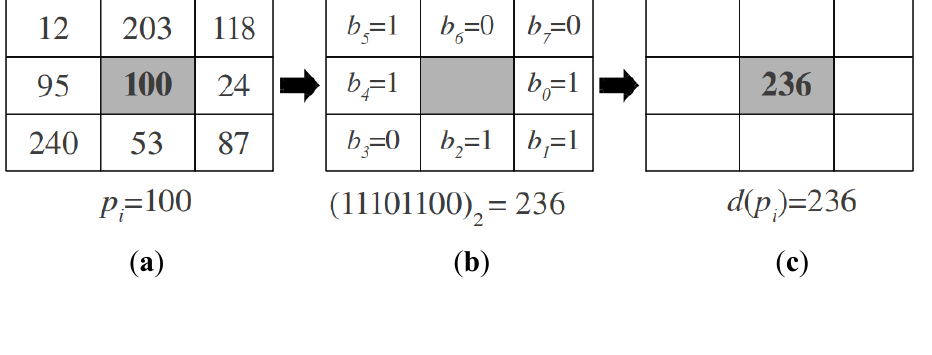
Figure 2. Toy example for the calculation of the LBP value of a pixel in a grey scale image. (marked in bold in a shadow cell) has an initial value of 100; ( a ) The reference pixel p i ( b ) Corresponding binary values for the 8-neighboring pixels of p into a binary string following a clockwise order starting at b value of 236; ( c ) The obtained decimal value is used as the new value for p transformed image T grey